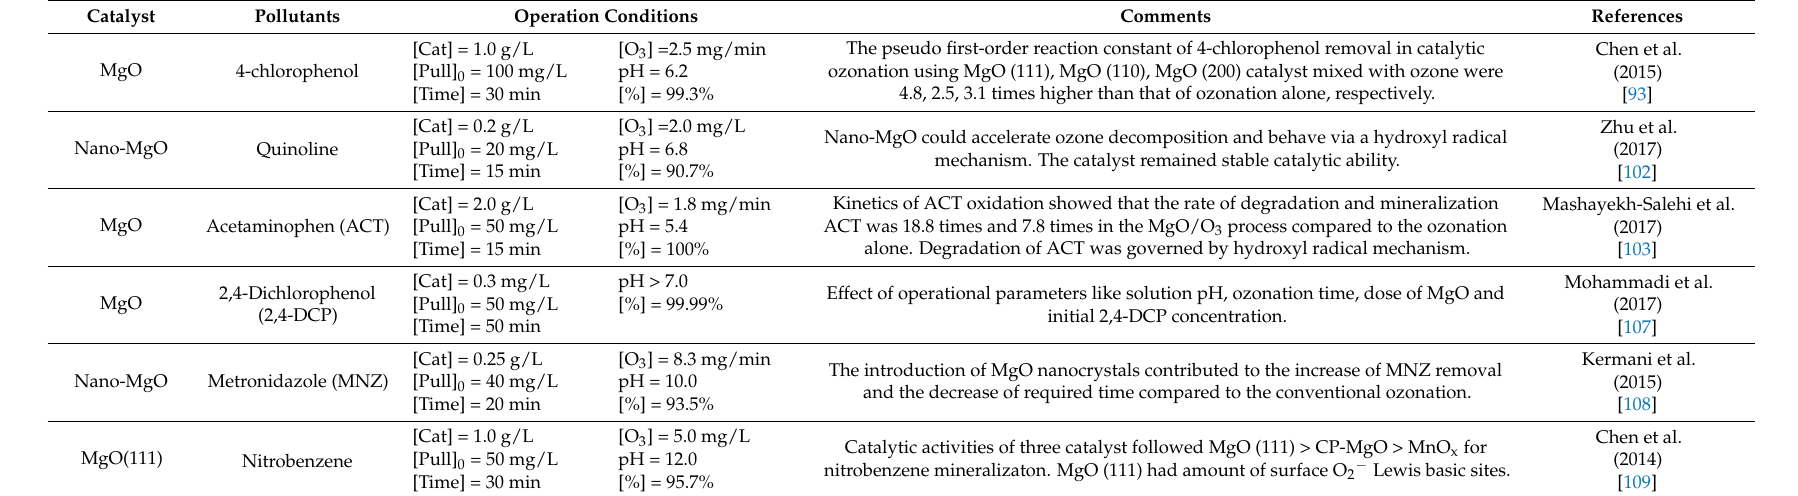
Table 7. Magnesium oxide for catalytic ozonation